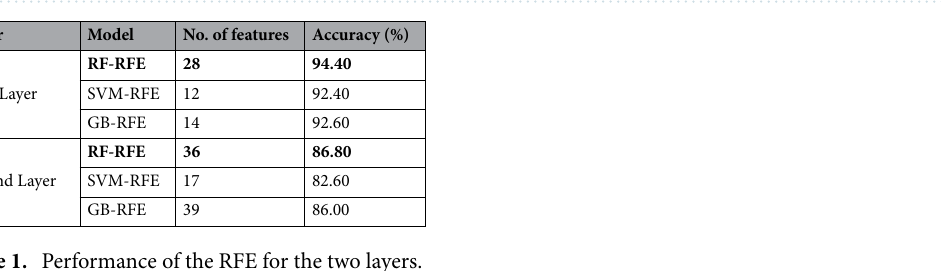
Table 1. Performance of the RFE for the two